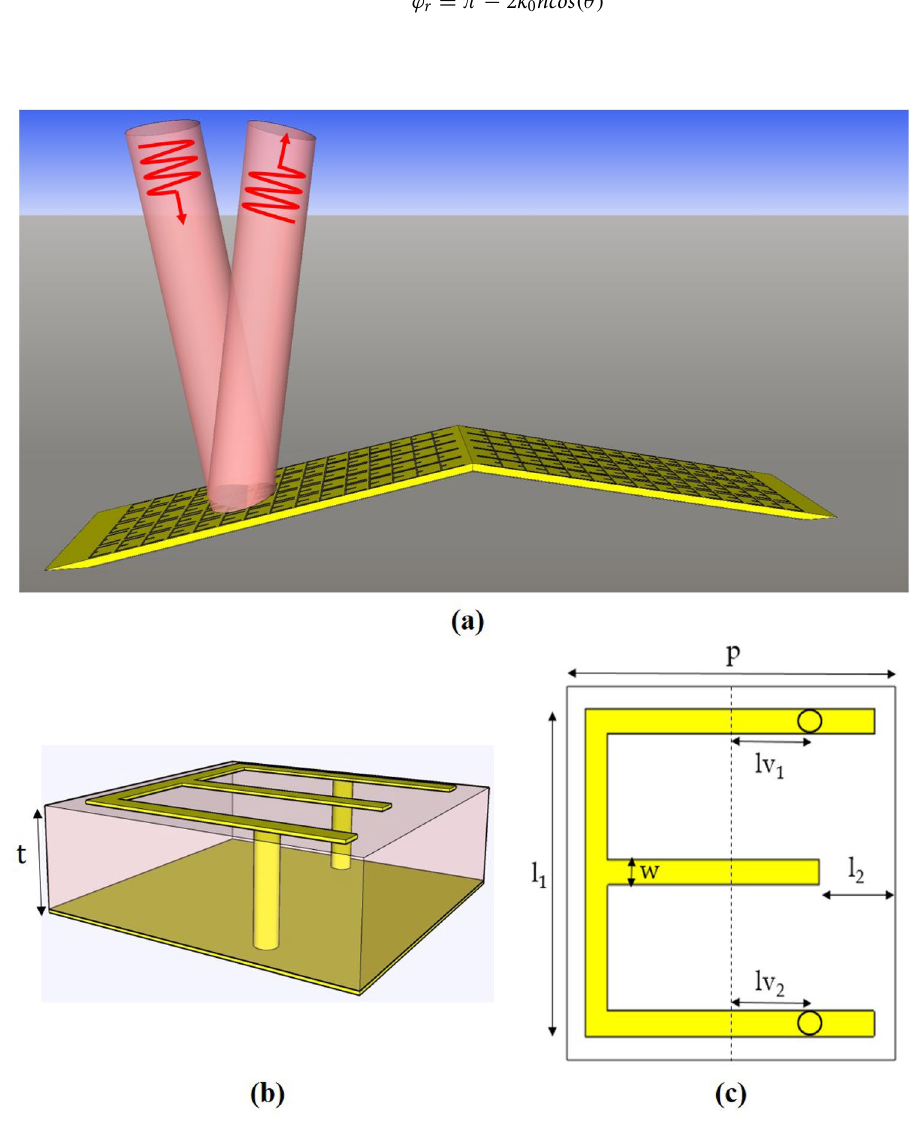
Figure 1. ( a ) Carpet invisibility cloak concealing objects under it consisting of 15 rows, each with a specific unit cell design. The structure of proposed unit cells’ ( b ) perspective view, and ( c ) top view. The parameters p , t , and w remain constant, while the other parameters, l 1 , l 2 , l v1 , and l v2 , are tuned to generate different